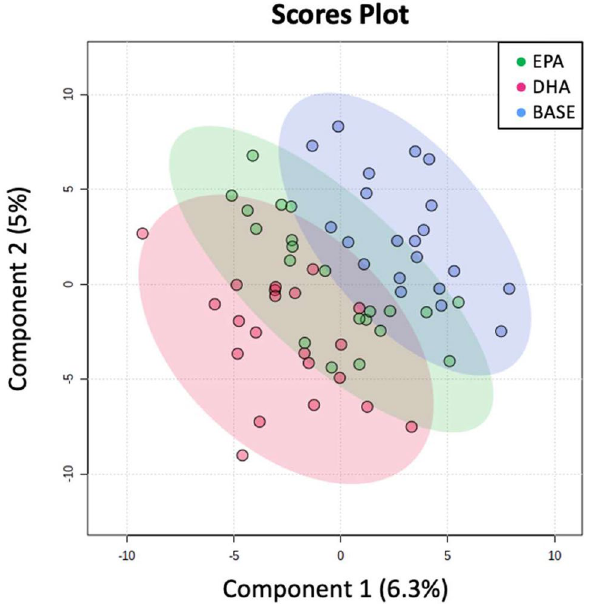
Figure 1. PLS-DA score plot. Primary metabolites are shown at baseline (blue) and at the end of the EPA (green) and DHA (red) supplementation